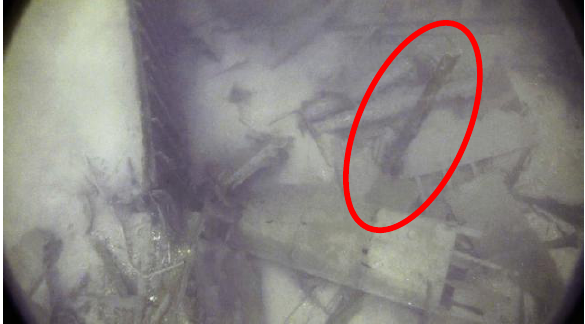
Figure 10: Video-frame with some fine and vertical elements in the structure of shipwreck